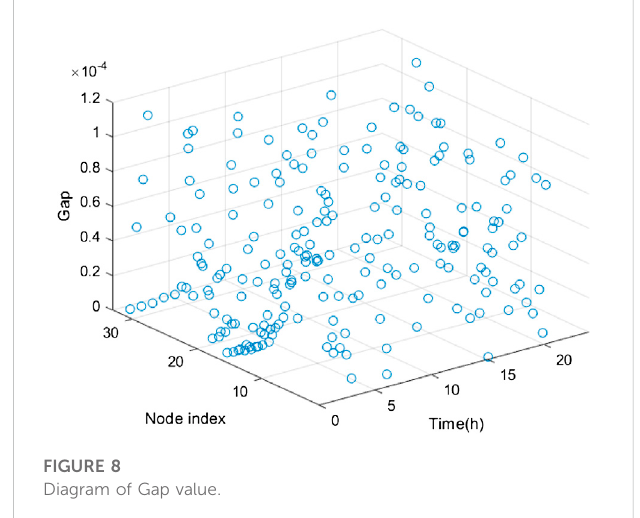
FIGURE 8 Diagram of Gap value.